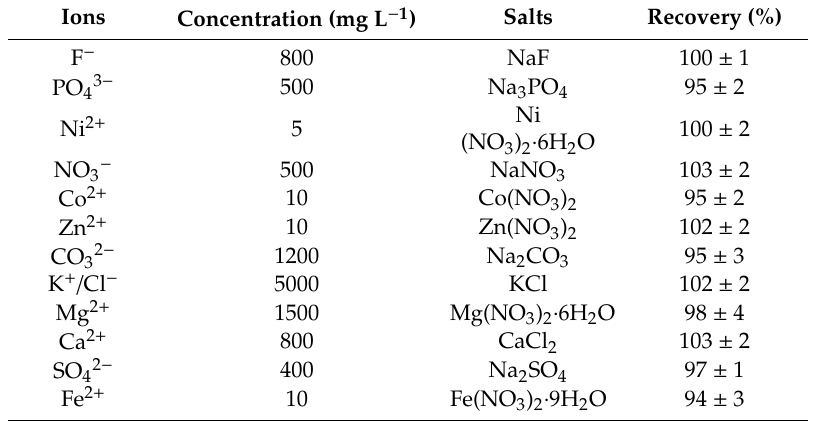
Recoveries of Pb(II) microextraction by deep eutectic solvent under various matrix applications ( n =